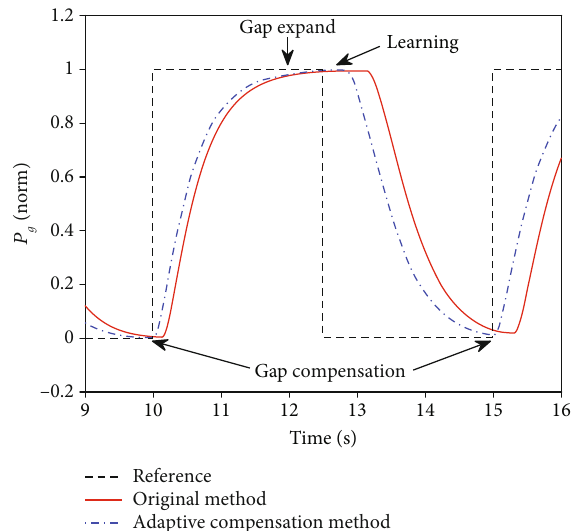
Figure 15: Simulation results of backlash compensation in an adaptive case.